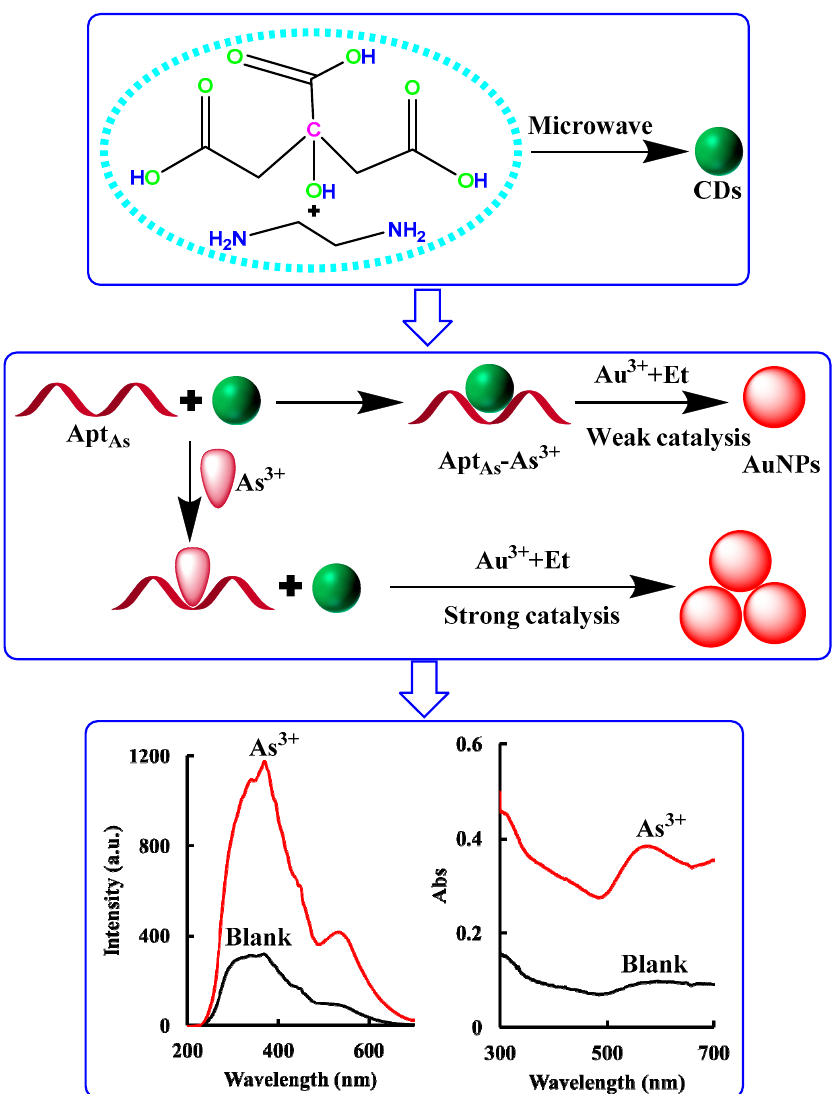
Figure 1. Principle of aptamer mediated nitrogen-doped carbon dot (CD N ) catalytic amplification– AuNP RRS/Abs dual-mode detection of trace As 3+ .